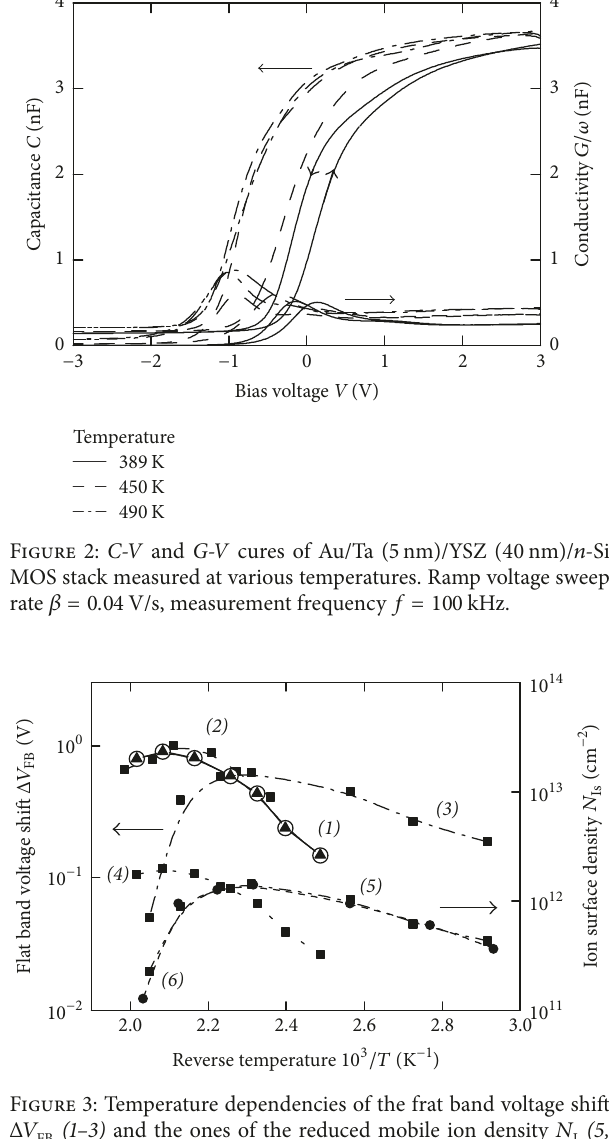
(5, I , cm −2 ⋅ eV −1 : (1, 2, ss